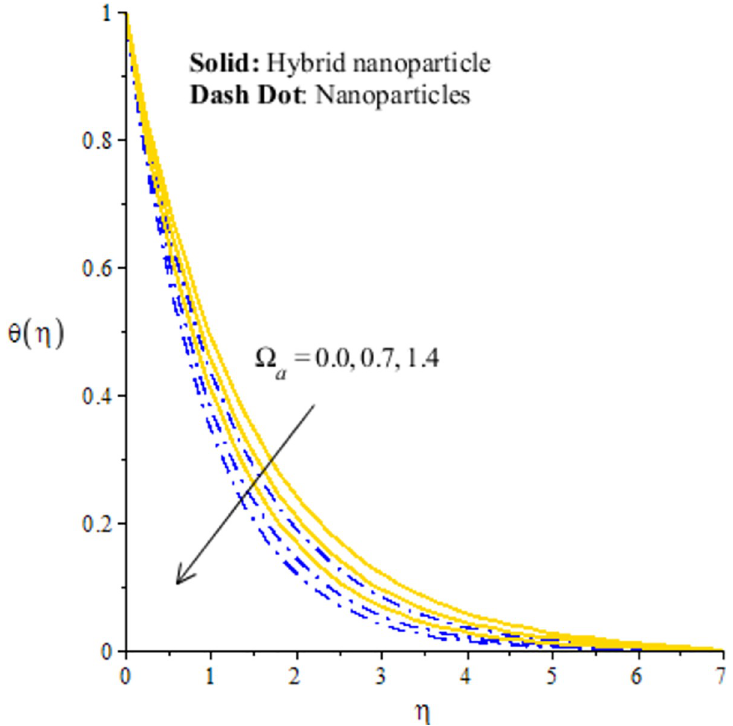
Fig 10. Distribution of temperature versus O